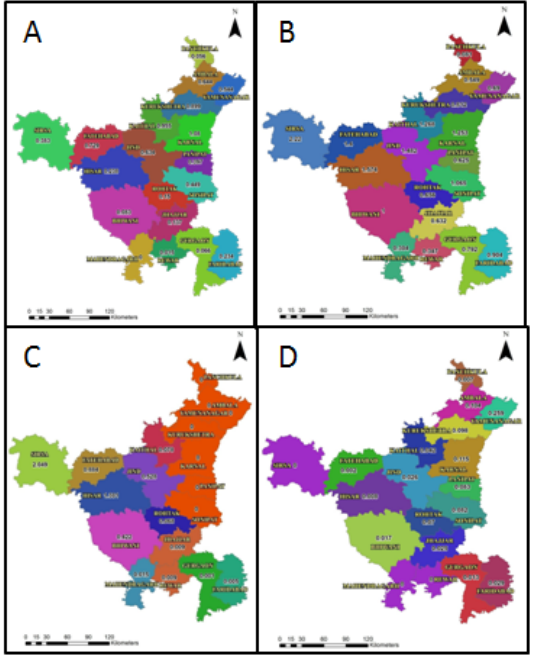
Fig. 3.1 District wise gross residue potential (MT) from (A) rice, (B) wheat (C) cotton, (D) sugarcane over Haryana